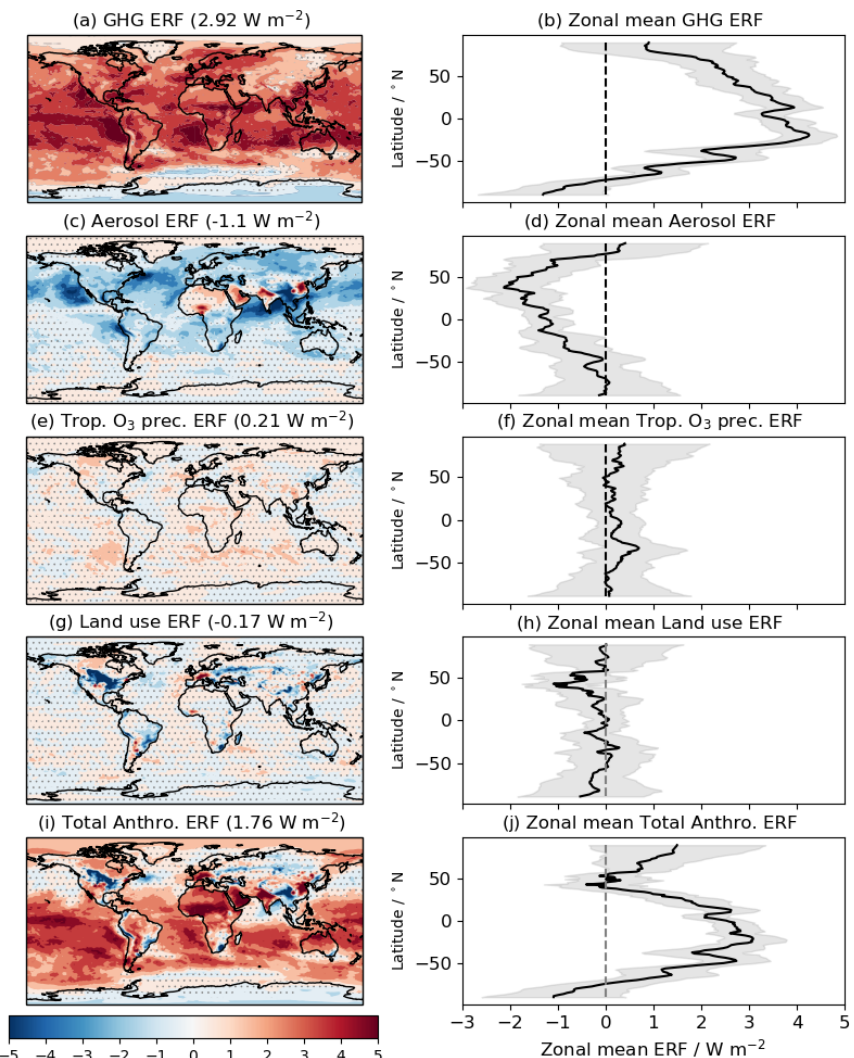
Figure 3. Geographical and zonal mean distributions of the present-day (PD; year 2014) ERFs relative to the pre-industrial (PI; year 1850) period in (a) and (b) for GHGs, in (c) and (d) for aerosols, in (e) and (f) for O 3 precursors, in (g) and (h) for LU change, and in (i) and (j) for total anthropogenic, respectively. In the global distribution plots, global mean ERFs are included and areas are stippled where the ERF is not statistically significant at the 95% confidence interval. In the zonal mean plots, the grey shading shows the ± 1 standard deviation in the zonal mean ERF. Units in Wm − 2